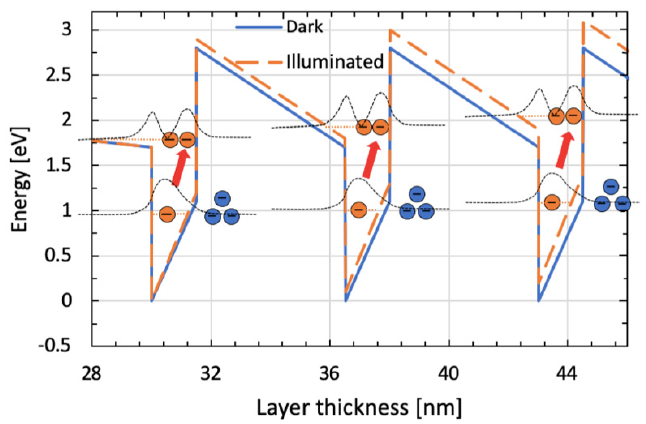
Figure 2. Schematic conduction band structure as a function of layer thickness (z-direction) of the SL gate region of a GaN/AlN-based detector monolithically integrated with an AlGaN-HFET. The solid blue line shows the potential for no illumination while the dashed orange one corresponds to an illumination level of 10 mW.